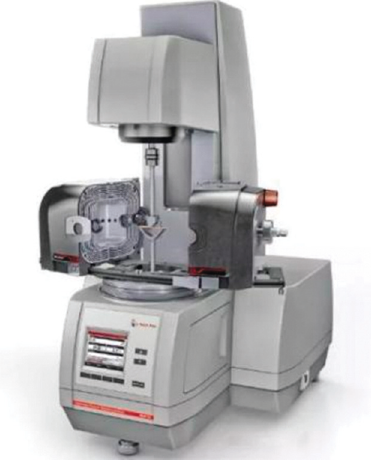
Figure 4: Dynamic shear